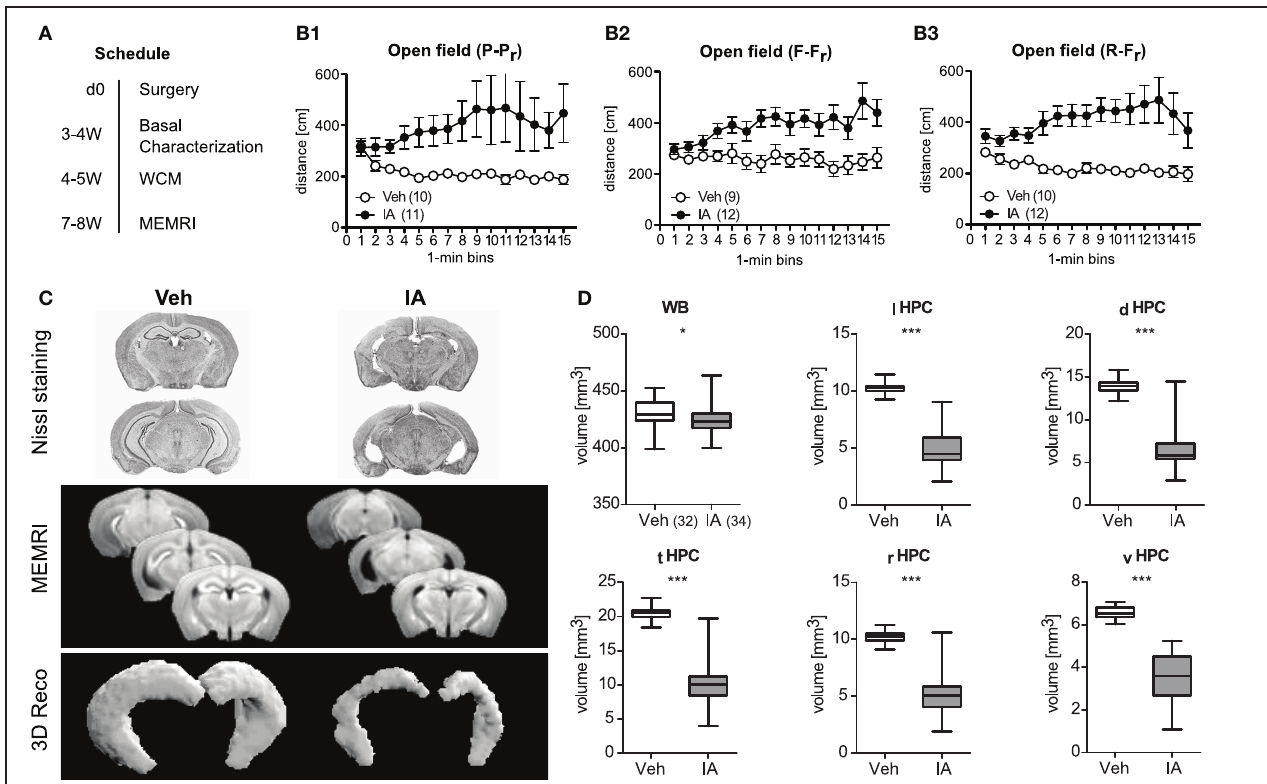
FIGURE 4 | Consequences of ibotenic acid lesions. (A) Schedule after surgery [d (day), week (W); for a summary of the results of the basal characterization see Table 1 ]. Panel (B1–B3) There were three independent batches of sham-operated (Veh) or ibotenic acid-lesioned (IA) mice. Veh controls habituated to the open field or at least stayed at a constant exploration level, whereas IA mice even showed a sensitized response in a highly replicable manner among three cohorts of mice ( Treatment: F ≥ 5 . 48, p ≤ 0 . 029; Treatment × Time: F ≥ 2 . 09, p ≤ 0 . 012). (C) In vivo manganese-enhanced magnetic resonance imaging (MEMRI)